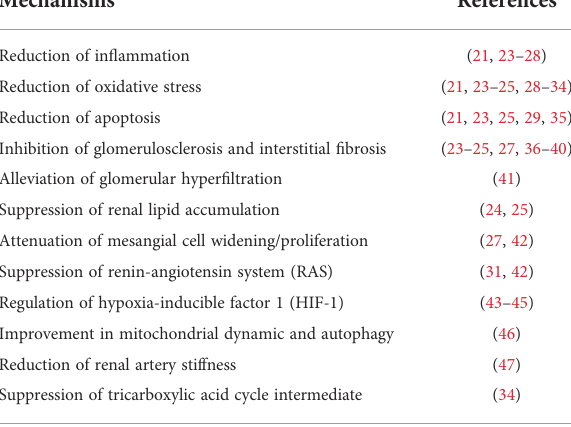
TABLE 1 Mechanisms of renoprotective effects of sodium-glucose cotransporters 2 (SGLT2) inhibitors in studies of multiple animal models. Mechanisms